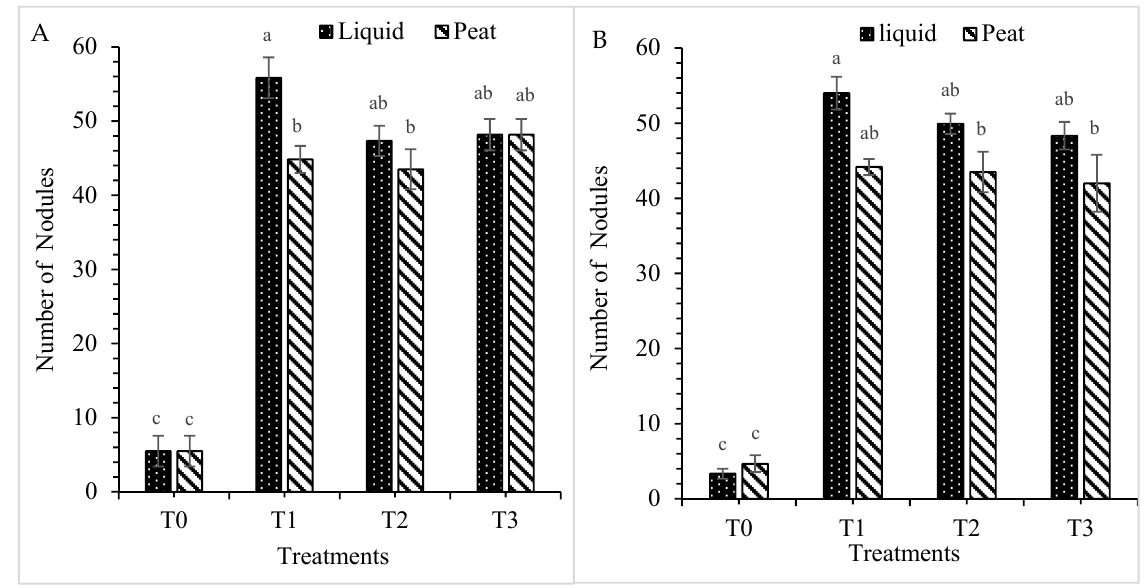
Figure 4. Number of nodules of soybean plants subjected to liquid formulation (T0 = 0 mL, T1 = 150 mL, T2 = 300 mL and T3 = 150 mL) and peat formulation of Bradyrhizobium japonicum (T0 = 0 g, T1 = 250 g, T2 = 500 g and 150 mL) in bioclimatic zone (( A ) = Bronkhorspruit/Gauteng) and (( B ) = Hartbeesfoein/North West province). Bars sharing a letter are not significantly different (Lsd zone A) = 10.167 and (Lsd zone B) = 9.978. Data are means ± standard errors.